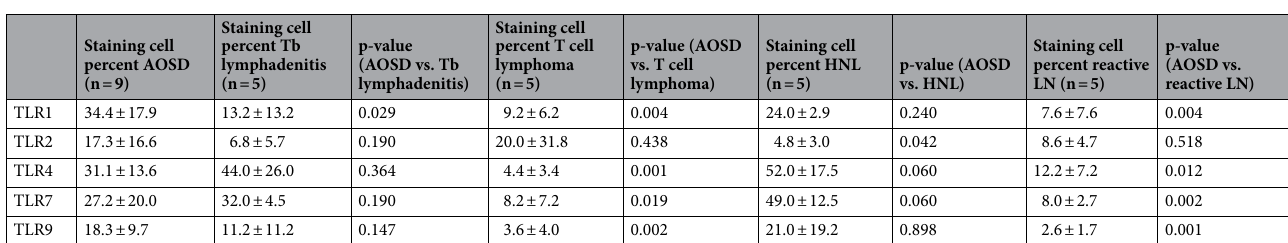
Table 5. Toll-like receptor (TLR) immunostaining results in lymph node (LN) biopsies from patients with adult-onset Still’ disease (AOSD) and other similar conditions. p-values determined using a Mann–Whitney U-test. AOSD, adult-onset Still’s disease; Tb, tuberculosis; HNL, histiocytic necrotizing lymphadenitis; LN, lymph